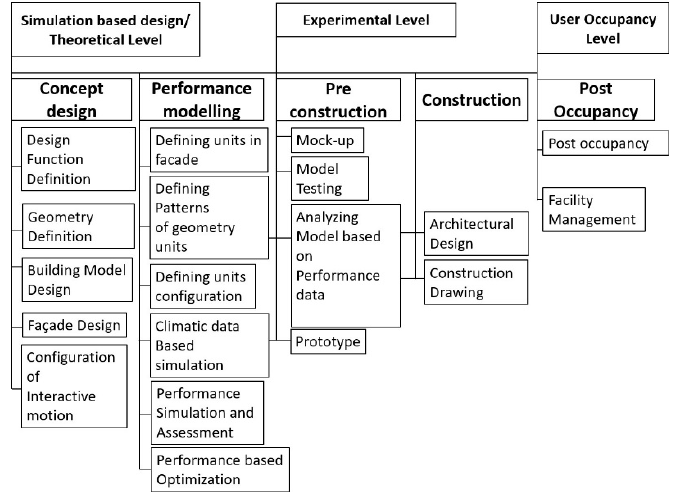
Figure 1. Existing Method of Interactive Facade Design.